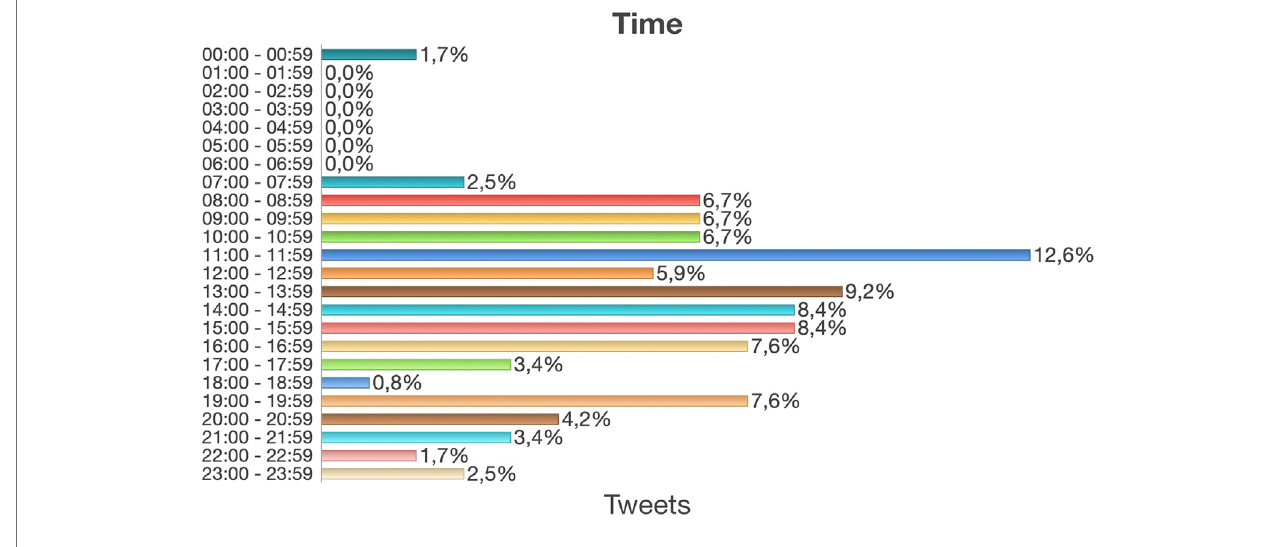
FIGURE 7 | Time of the day of the Congo Check posts.